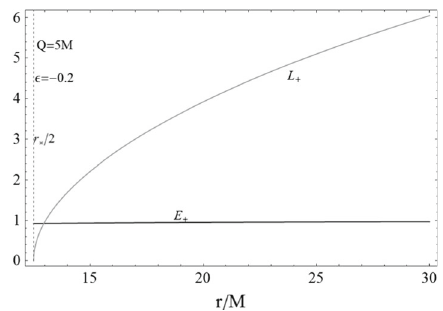
√ Fig. 28 Class : Q > 9 / 8 M and (cid:2) = − M / Q . Parameter choice is as follows: Q = 5 M and (cid:2) = − 0 . 2. Then r + s = 16 M . Circular orbits exist with angular momentum L = L + ( gray curve ) and energy E = E + ( black curve ) in the region r > Q 2 /( 2 M ) . For r = Q 2 /( 2 M ) , L =